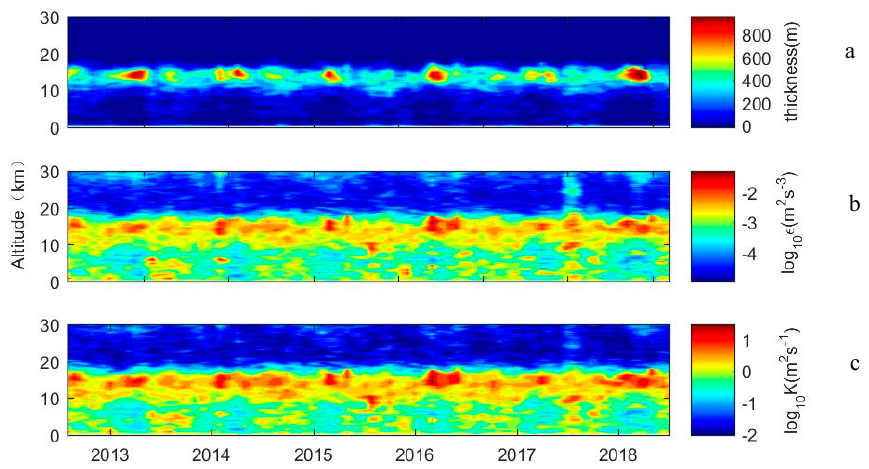
Figure 9. Time series of atmospheric column characteristics from 2013 to 2018: ( a ) overturn size, ( b ) turbulent kinetic energy dissipation rate, ( c ) turbulent di ff usion coe ffi cient.